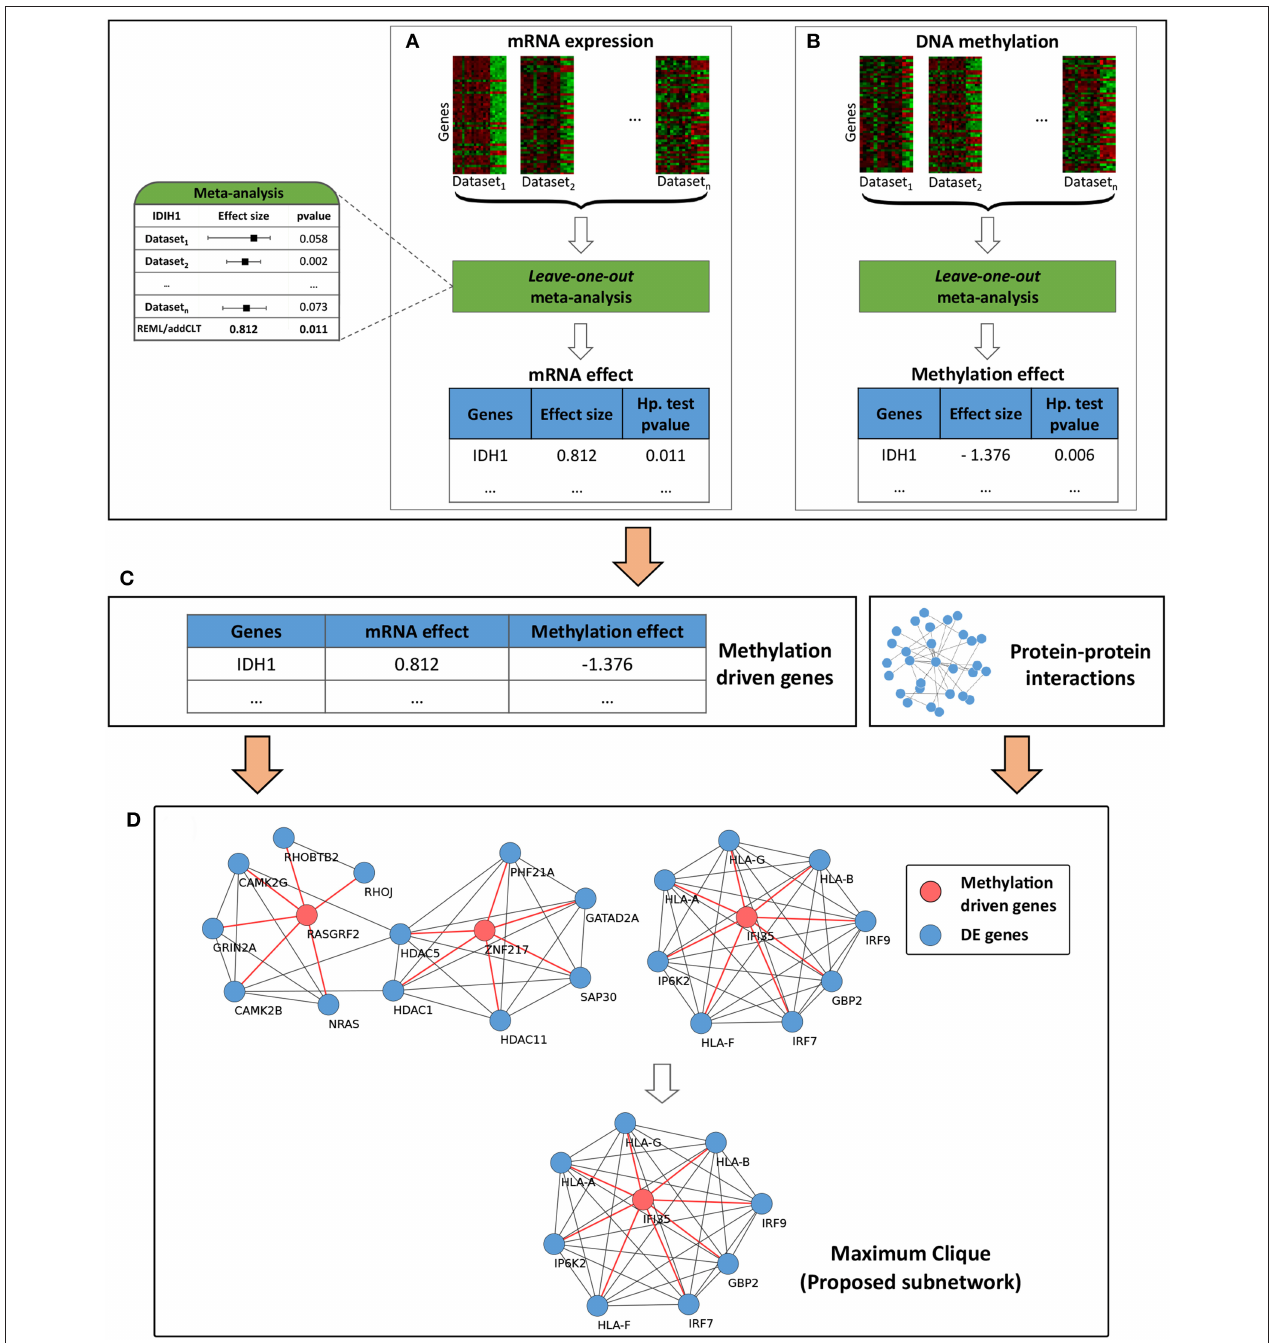
FIGURE 1 | Overall workflow of the proposed framework. Module (A) takes multiple independent mRNA datasets and performs a leave-one-out meta-analysis to identify reliable differentially expressed genes (DEGs). Similarly, module (B) takes multiple independent DNA methylation datasets and identifies differentially methylated genes (DMGs). DEGs and DMGs are then systematically integrated in module (C) to identify methylation-driven genes (MDGs). Finally in module (D) , the MDGs are used as inputs in a network propagation algorithm to identify the proposed